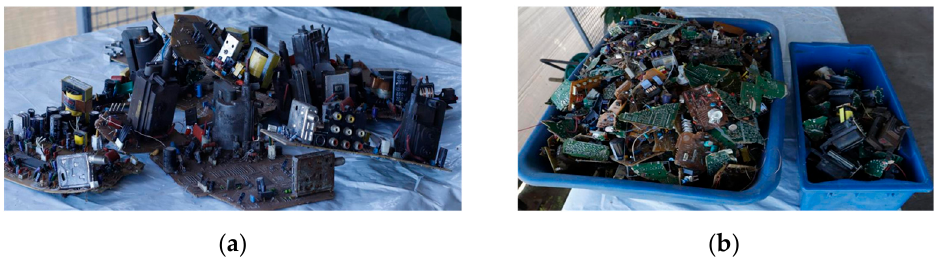
Figure 1. ( a ) Raw PCBAs samples. ( b ) Samples after dismantlement: PCBs (left) and voltage and flyback transformers (right). flyback transformers